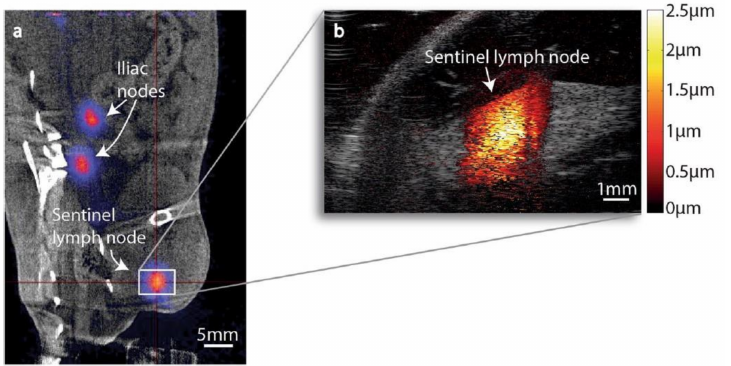
Figure 19. ( a ) Coronal PET/CT image of animal 1. The centre of the red cross shows the position of the nanoparticle-accumulated sentinel lymph node. Nanoparticle accumulation can also be seen in two iliac lymph nodes. ( b ) MMUI image of the same sentinel lymph node. Figure adapted from [152], Copyright 2017 Nature Research.